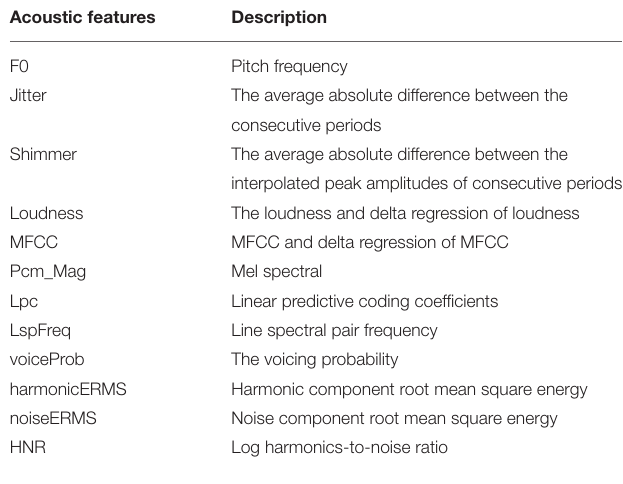
TABLE 1 | Frame-level speech